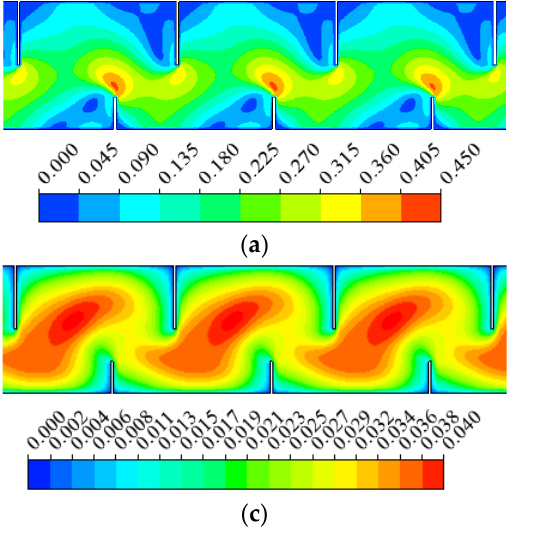
Figure 2. The hydraulics distribution: ( a ) velocity (m/s), ( b ) vector (m/s), ( c ) turbulence kinetic energy (m 2 /s 2 ) and ( d ) strain rate (s −1 ) in pool 2 – 4 at z = 0.3 h, respectively.